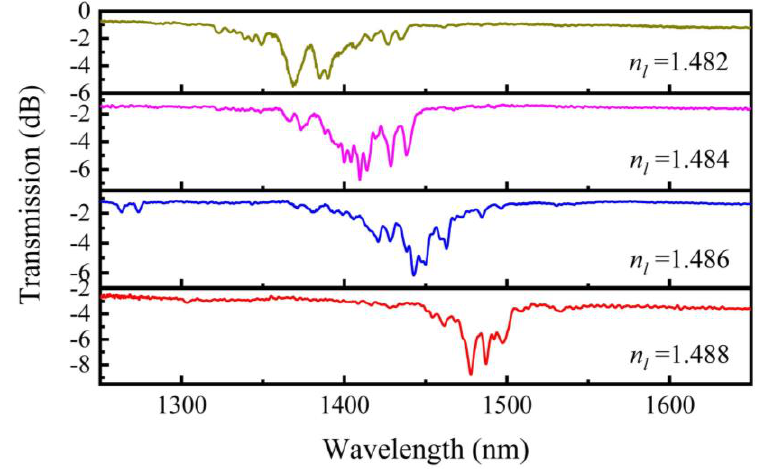
Figure 10. Transmission spectra of LFTPCFs filled with standard RI liquid as well as RIs that varied from 1.482 to 1.488 in intervals of 0.002.